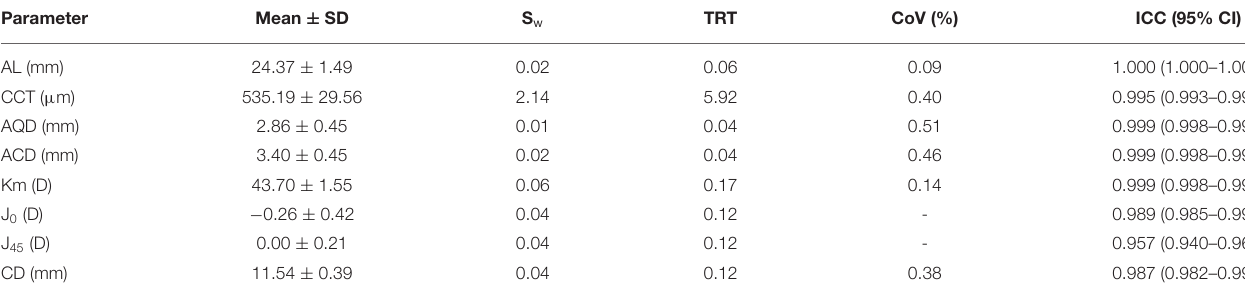
TABLE 2 | Interobserver reproducibility outcomes for biometric measurements obtained using the new Scheimpflug imager in combination with partial coherence interferometry biometer.